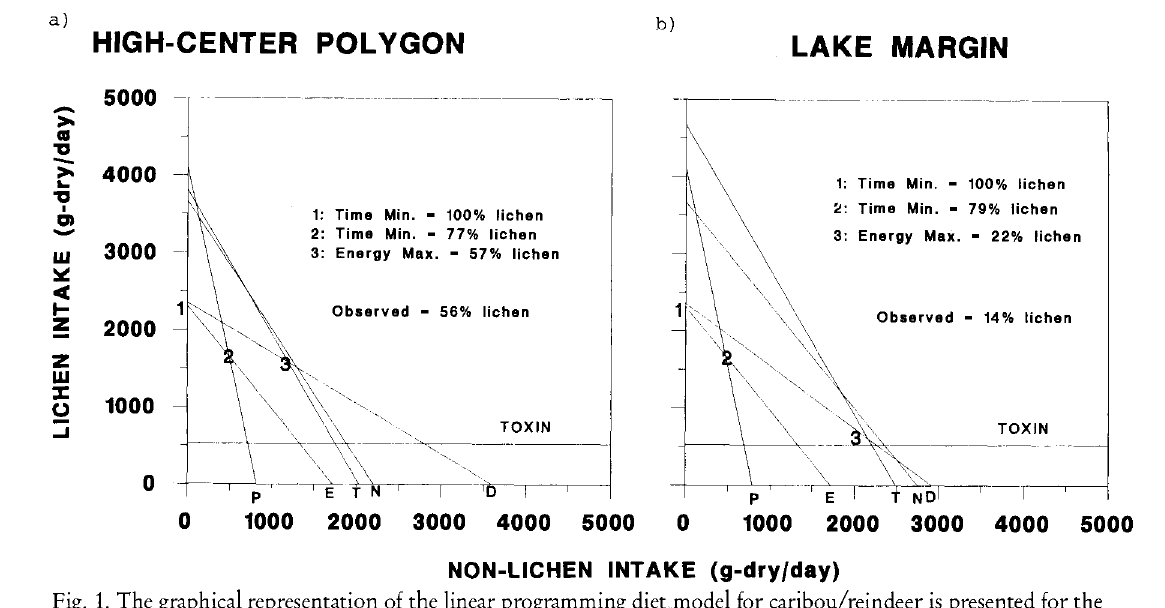
Fig. 1. The graphical representation of the linear programming diet model for caribou/reindeer is presented for the high-centre polygon habitat (a) and the lake margin habitat (b). The letters along the x-axis identify the con straints (Tables 1-4) (P is protein, E is energy, T is feeding time, N is sodium, D is digestive processing), and the flat line parallel to the x-axis is labelled TOXIN for secondary compounds. Each graph presents the observed diet and 3 solutions to the model (ignoring the toxin constraint, see text): 1) the time-minimized diet based only on an energy requirement; 2) the time-minimized diet based on energy and protein requirements; 3) the energy- maximized diet, ignoring the sodium requirement (see